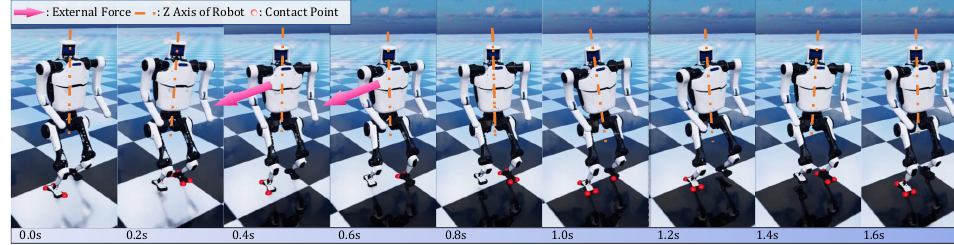
Figure 9. Snapshots of recovering from pushing force. Orange dashed lines refers to the Z axis of robot frame (Corresponding video of the snapshots can be found in Supplementary Materials).